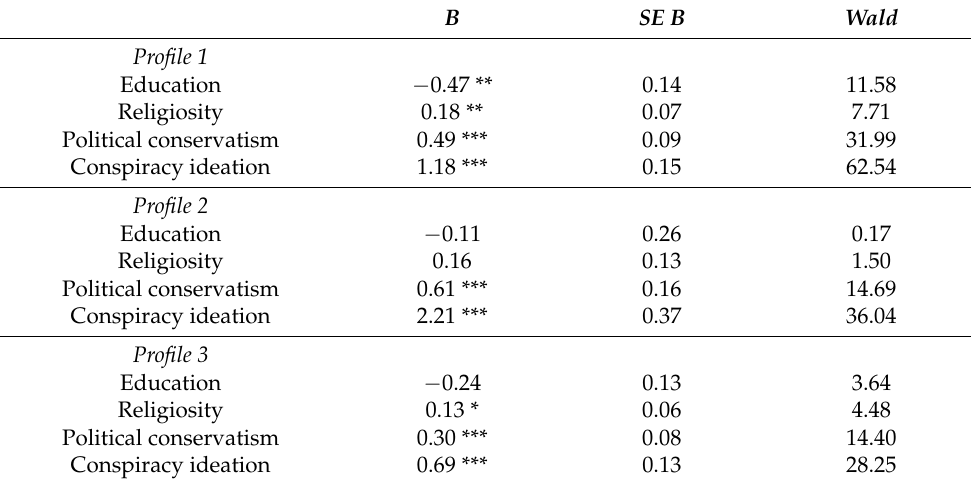
Table 6. Summary of parameter estimates for variables predicting profile